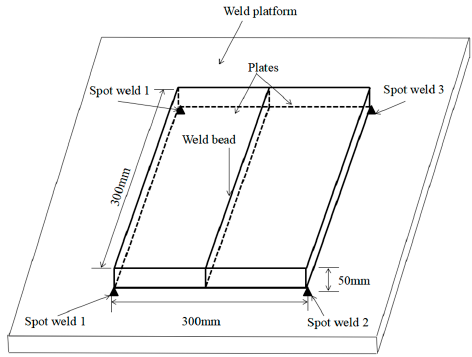
Figure 2. Diagram of the dimension and clamp conditions of the testing coupon.